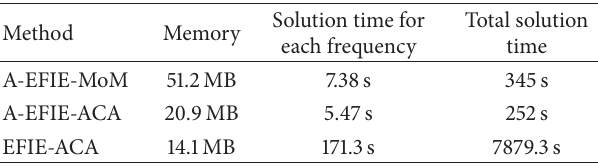
Figure 9: S11 and S12 for a dual-mode dual-band BPF. Table 4: The memory requirement and solution time for a dual- mode dual-band